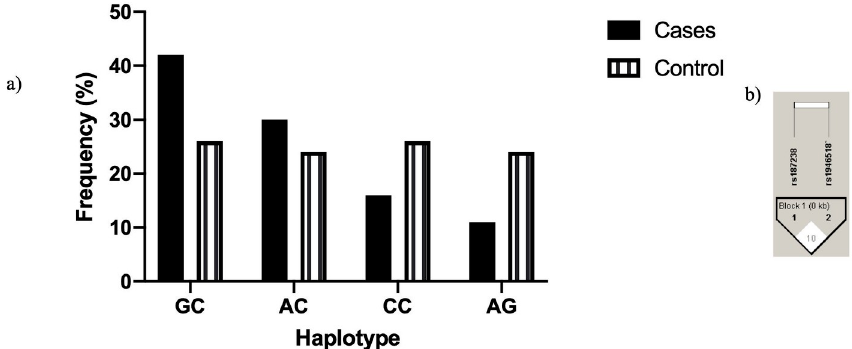
Fig 1. Different haplotypes in rs1946518 rs187238 positions in IL-18 promotor a) Frequency of different haplotypes. b) Linkage equilibrium between the 2 SNPs in IL-18